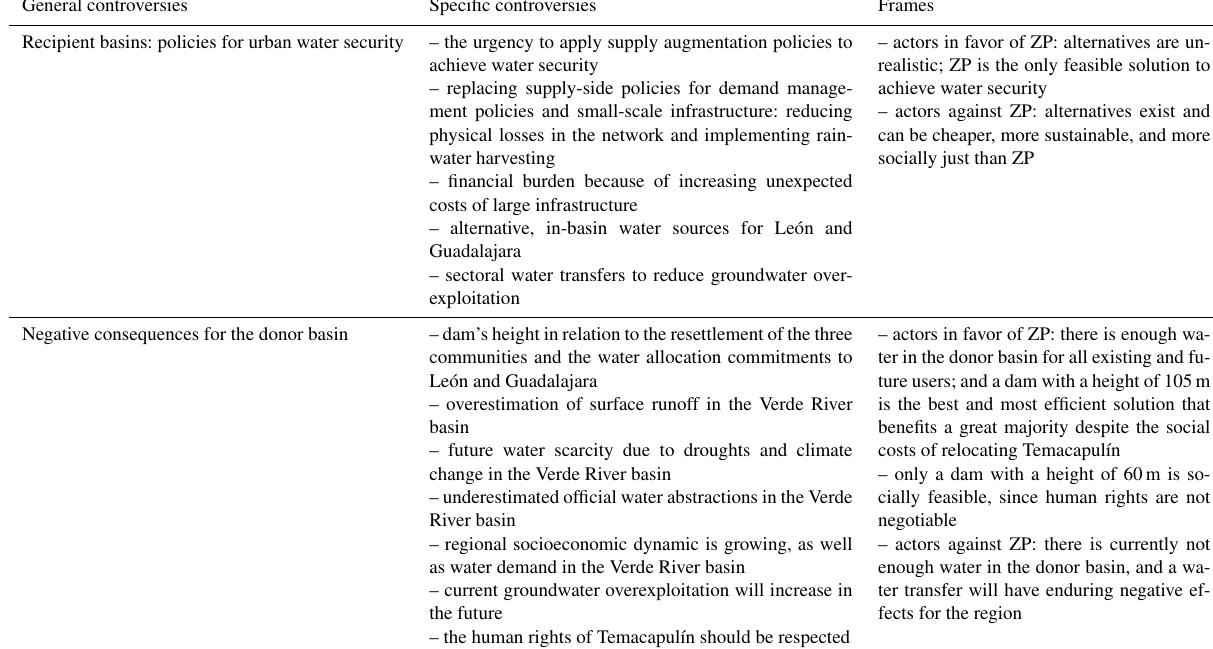
Table 1. Main controversies and frames on the coupled human–water system of the regions and the Zapotillo project